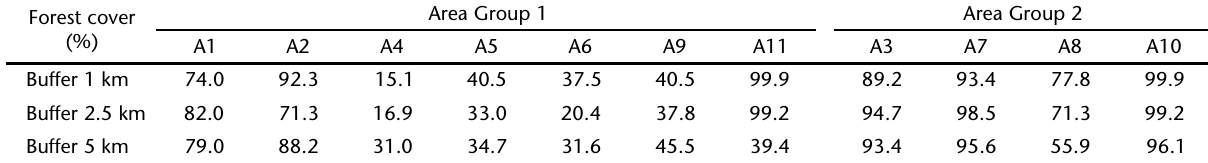
Table III. Percent of forest cover in the surroundings of the remnants of the Atlantic Forest of the hydrographic basin of the Itajaí River, Santa Catarina, between April and August, 2007. Forest cover